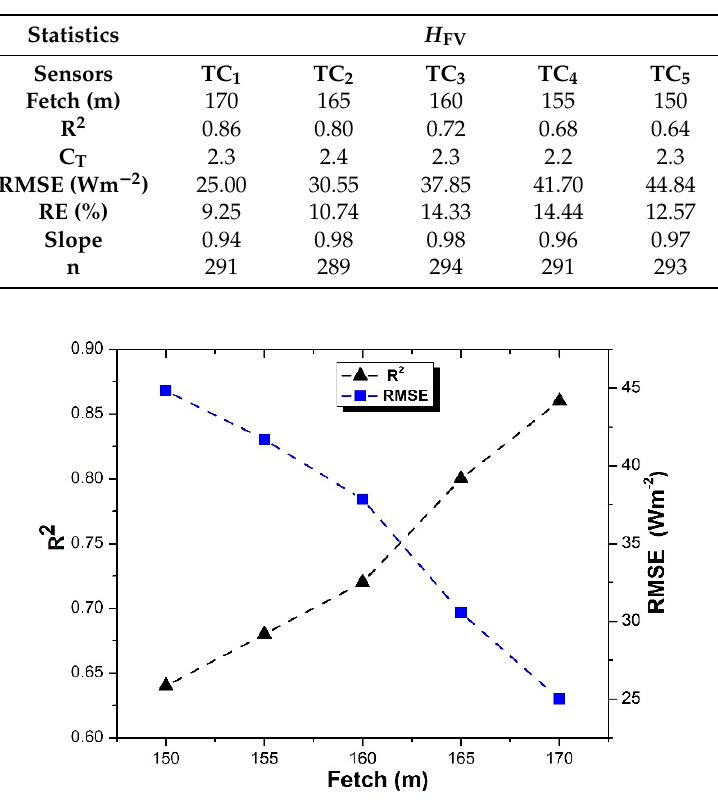
Figure 7. Variation of R 2 and RMSE for H FV vs H EC along fetch.